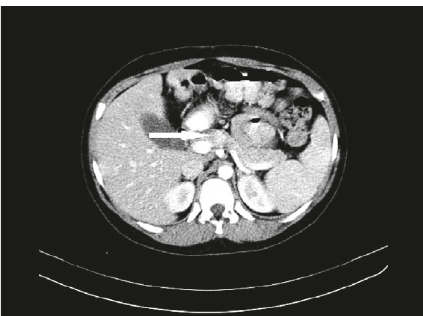
Figure 1: Abdominal CT scan with enhanced mass at the neck of pancreas (arrow).